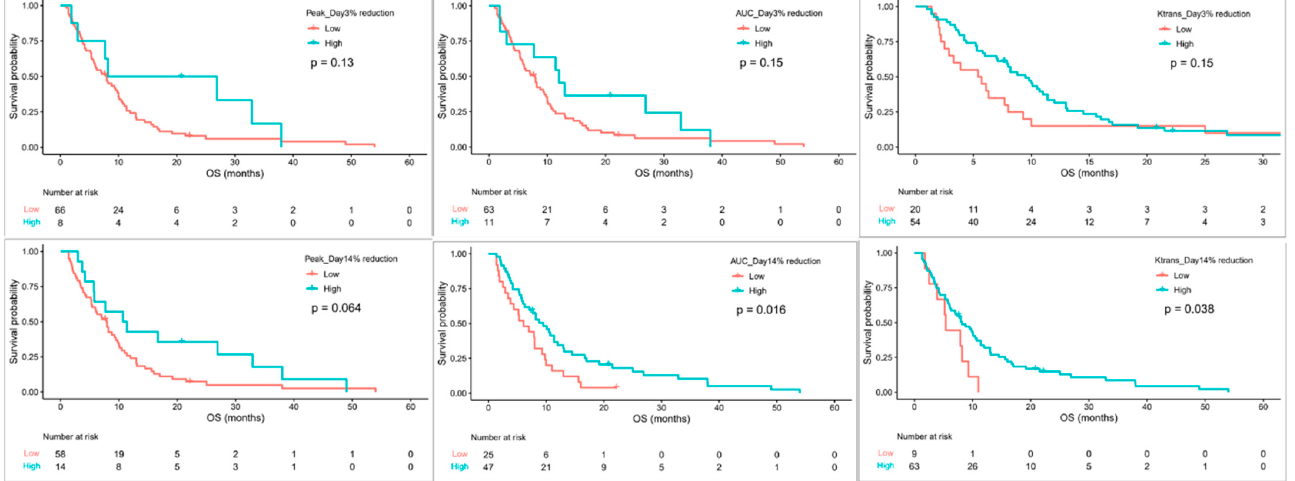
Figure 4. Kaplan – Meier survival curves of OS grouped by changes in DCE-MRI biomarkers on day 3 and day 14.